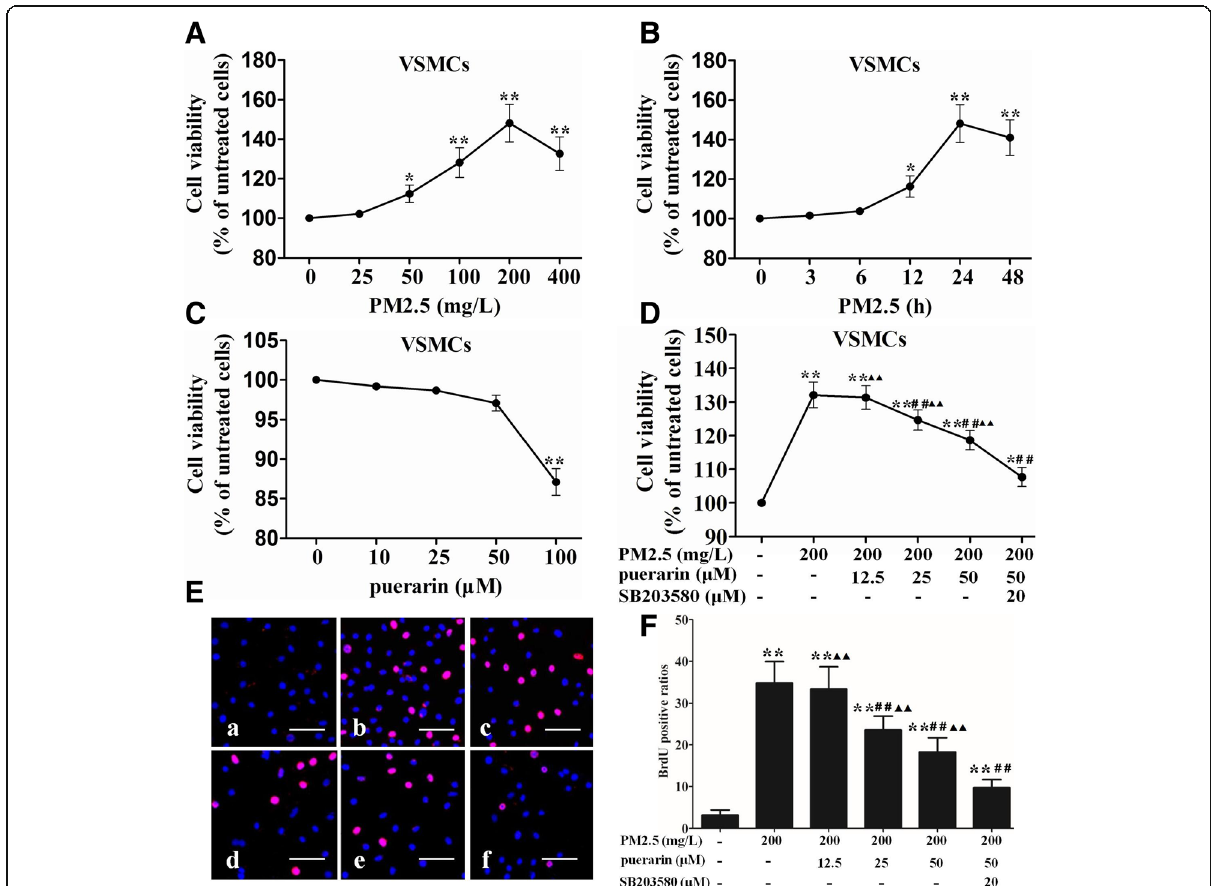
Fig. 3 Effect of puerarin on VSMCs proliferation. VSMCs viability was assessed by CCK-8 assay. a Cells were stimulated with different concentrations of PM2.5 (0, 25, 50, 100, 200, 400 mg/L) for 24 h. b Cells were stimulated with 200 mg/L PM2.5 for the different time points (0, 3, 6, 12, 24, 48 h). c Cells were stimulated with different concentrations of puerarin (0, 5, 10, 25, 50, 100 μ M) for 24 h. d Cells were pre-treated with puerarin at different concentrations (0, 12.5, 25, 50 μ M) or p38 MAPK inhibitor SB203580 (20 μ M) for 1 h and followed by the addition of 200 mg/L PM2.5 for 24 h. VSMCs proliferation was measured according to the BrdU immunofluorescence. e Confocal images. a, the untreated cells; b, cells were stimulated with 200 mg/L PM2.5 for 24 h; c, cells were pre-treated with 12.5 μ M puerarin for 1 h and followed by the addition of 200 mg/L PM2.5 for 24 h; d, cells were pre-treated with 25 μ M puerarin for 1 h and followed by the addition of 200 mg/L PM2.5 for 24 h; e, cells were pre-treated with 50 μ M puerarin for 1 h and followed by the addition of 200 mg/L PM2.5 for 24 h; f, cells were pre-treated with 50 μ M puerarin and p38 MAPK inhibitor SB203580 (20 μ M) for 1 h and followed by the addition of 200 mg/L PM2.5 for 24 h. Bars =100 μ m. f Graphs of BrdU positive ratios. The results are presented as mean±SEM. n =3. Compared to the untreated cells, * P <0.05, ** P <0.01; compared to 200 mg/L PM2.5 group, # P <0.05, ## P <0.01; compared to the co-incubation of puerarin with SB203580 group, ▲ P <0.05, ▲▲ P